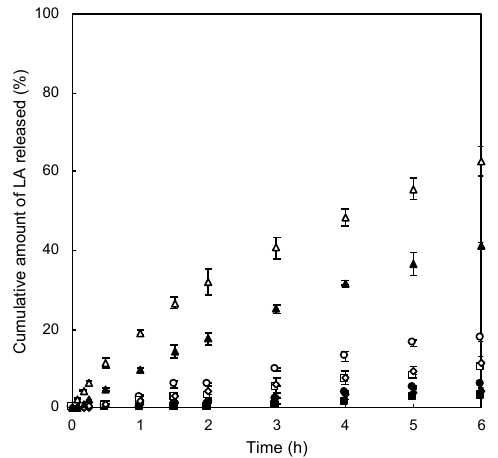
Figure 7. LA release profile from each formulation against the time as the X-axis. Symbols; O: MP 1.0 , : MP 5.0 , : MP 10 , : Phy-MP 10 , : P, : Phy-P, : Lipo 1.0 , : Lipo 10 . Each value shows the mean ± S.E. ( n = 3–5).